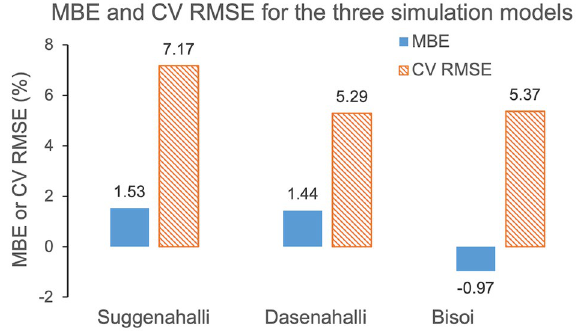
Figure 5. MBE and CV RMSE between measured and simulated temperature data for the dwellings in the three settlements: Figure shows the Mean Bias Error (MBE) and Coefficient of Variation of Root Mean Square Error (CV RMSE) in percentage calculated between the measured and simulated indoor air temperature data for the dwellings studied in each of the three settlements. The blue coloured solid bar shows MBE, while orange coloured bar with diagonal stripes shows CV RMSE. Both MBE and CV RMSE for all the three settlements are within the limits prescribed by ASHRAE 14